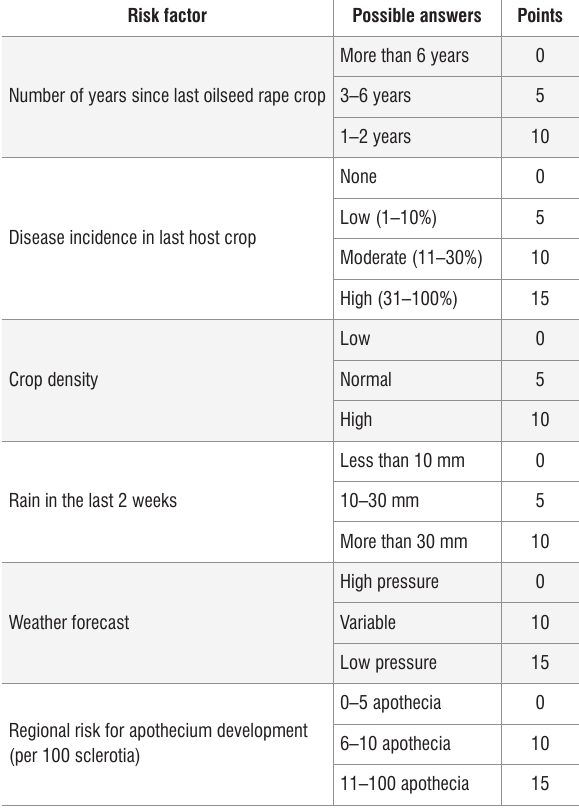
Forecasting model for Sclerotinia stem rot of canola 4